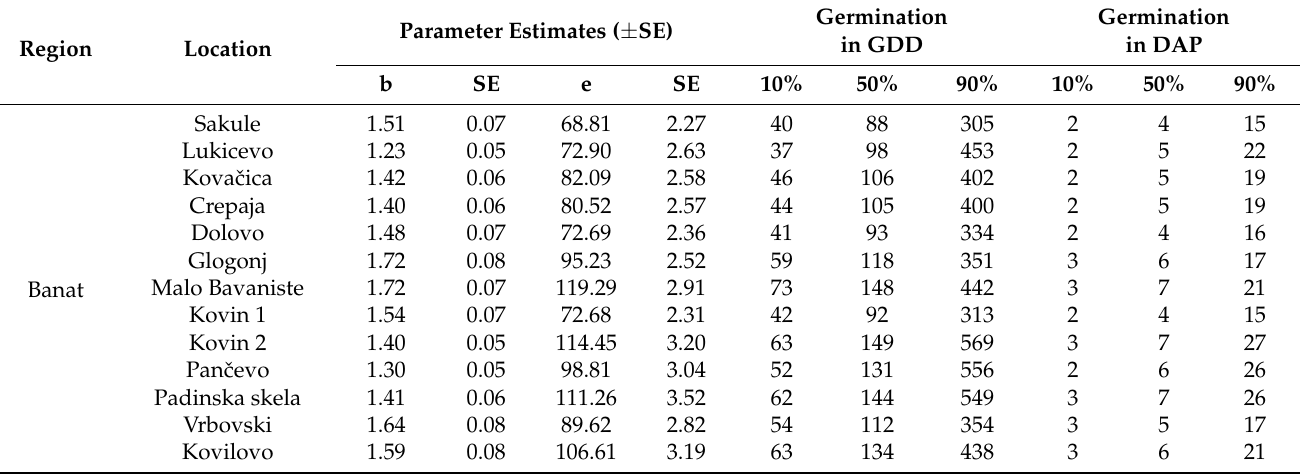
Table A3. Region by location models (no